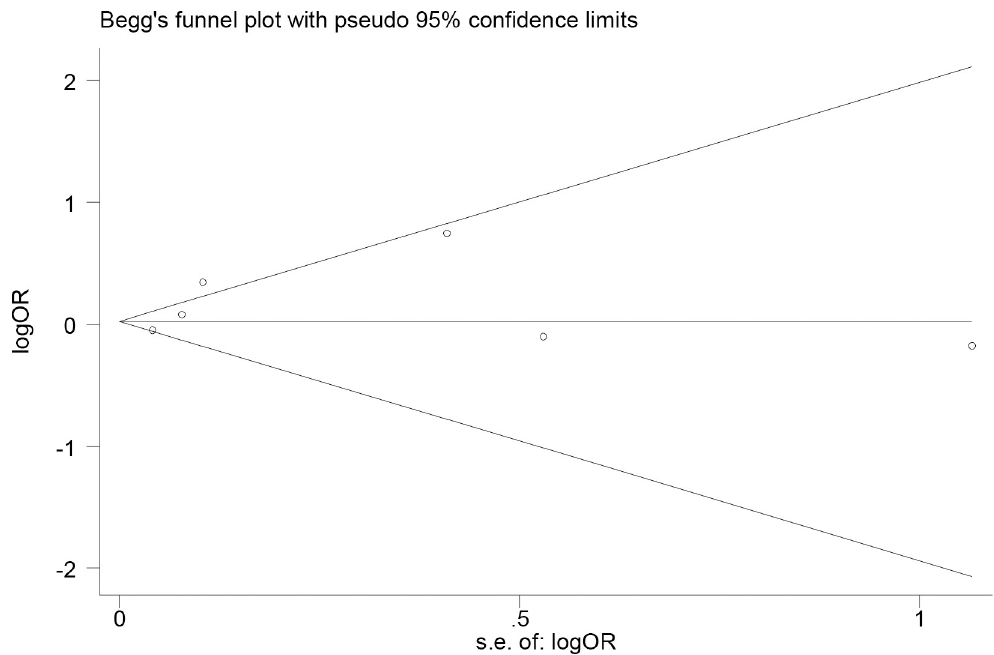
Fig 3. Begg’s funnel polt for publication bias. Logor, the logarithmic function values of odds ratio; s.e. of logor, the standard error of the logarithmic function values of odds ratio.